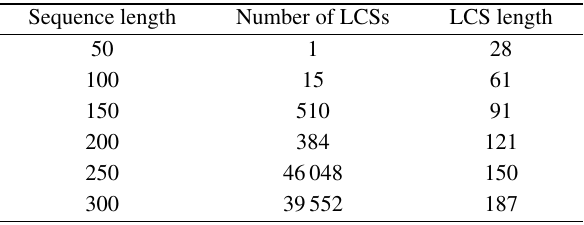
Table 1 LCS experimental results of input sequences with different lengths.